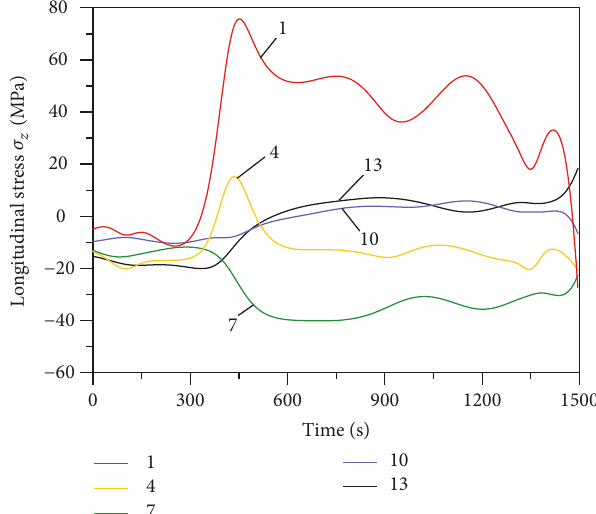
Figure 7: Longitudinal thermal stress transients in seven points on the outlet header inner surface.